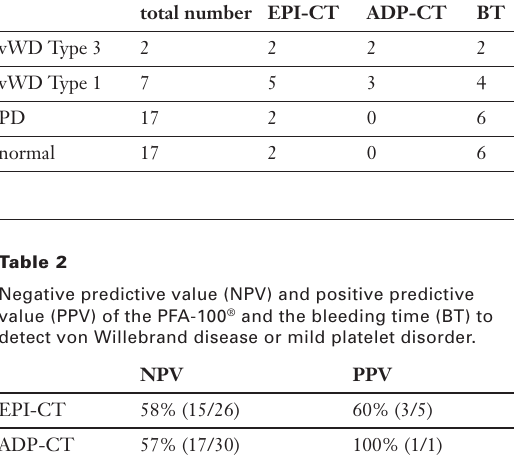
NPV and PPV were calculated on the basis of 31 consecutive outpatients with a bleeding tendency.